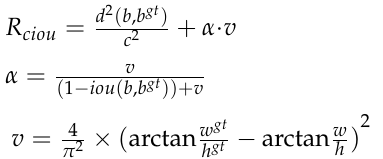
of positive samples, which further promoted the network’s convergence.